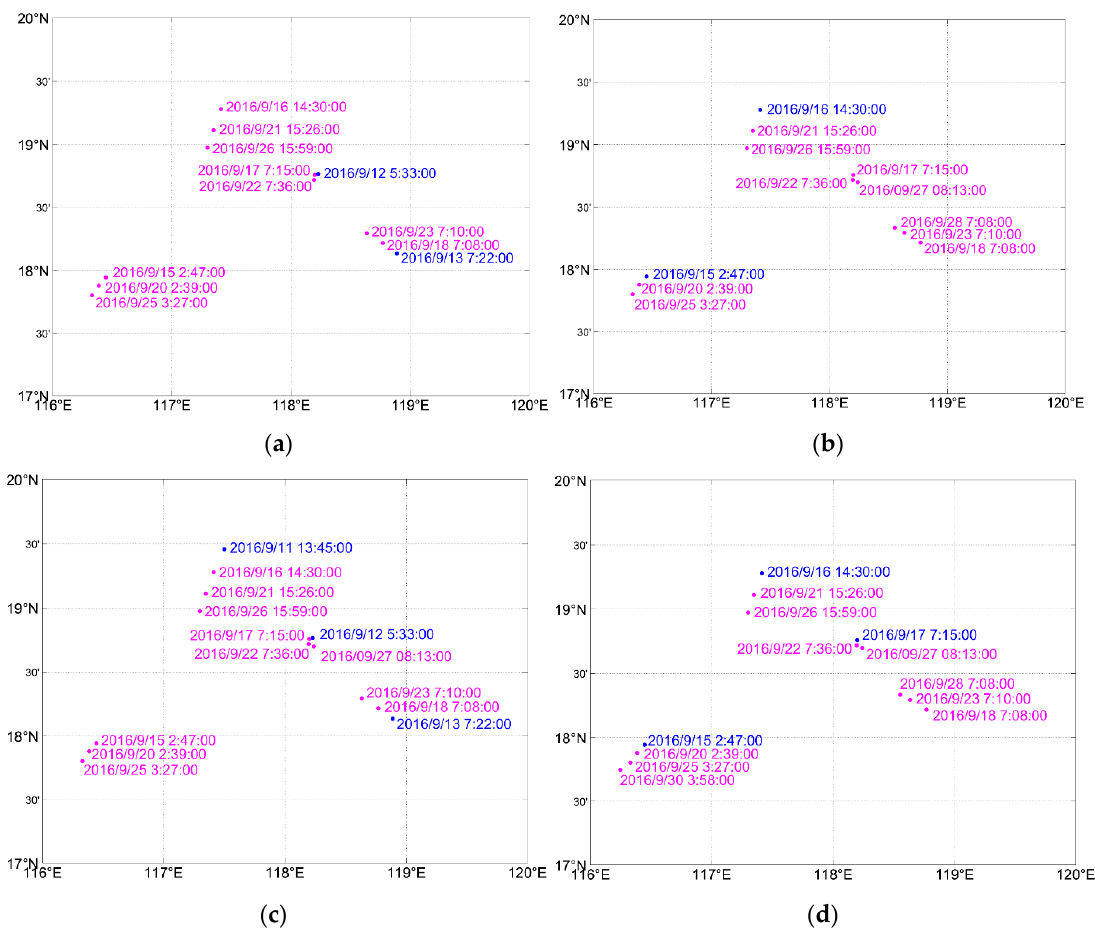
Figure 4. The spatial distribution of Argo at different times. ( a ) Experiment 1; ( b ) Experiment 2; ( c ) Experiment 3; ( d ) Experiment 4.